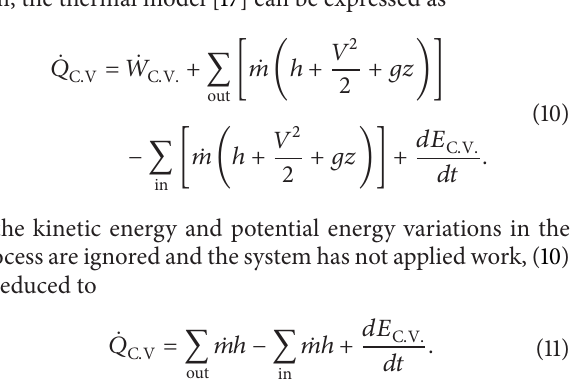
Equation (6) can be reduced to vapor mass